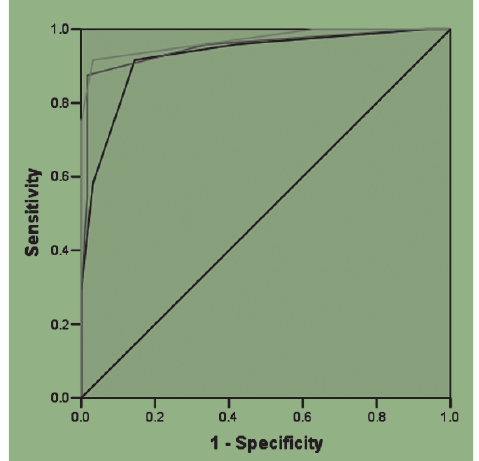
Figure 1: Receiver Operating Characteristics Curve of EWS on Day 1, 2 and